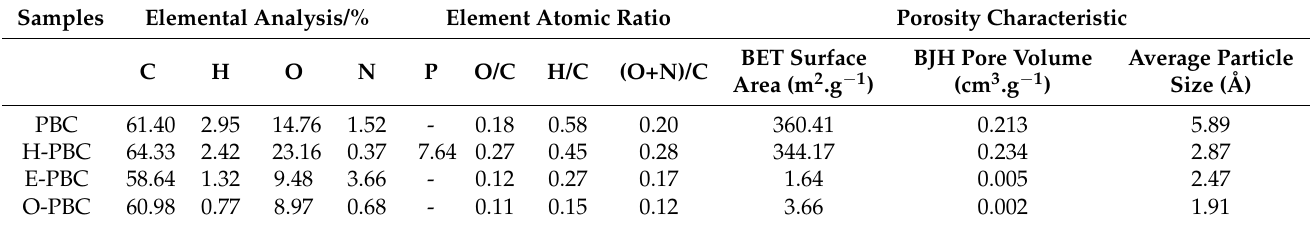
Figure 2. ( A ) Brunauer-Emmett-Teller spectra, ( B ) pore size distributions, ( C ) X-ray diffraction patterns, and ( D ) Fourier-transform infrared spectra obtained for PBC, E-PBC, O-PBC, and H-PBC. Table 1. Element and porosity characteristic of PBC, H-PBC, O-PBC, and E-PBC.